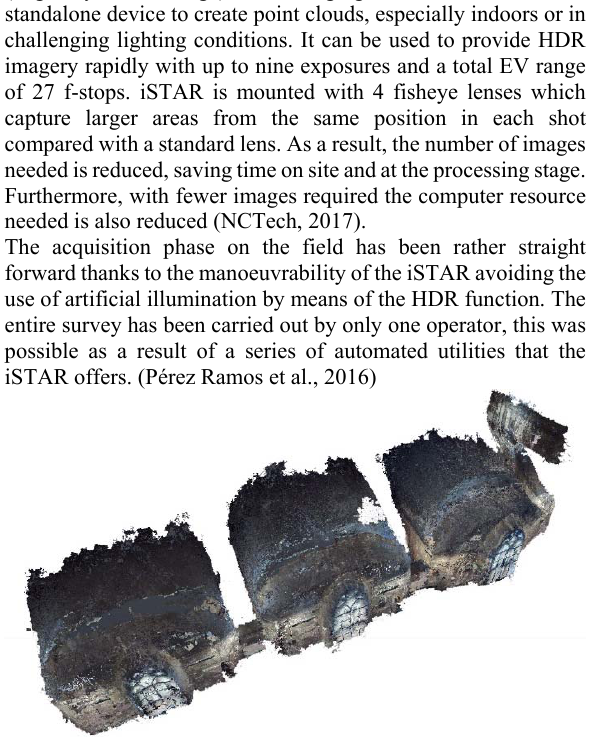
Figure 8. The NCTech iSTAR point cloud, 17.335.313 points, 1,1 GB.